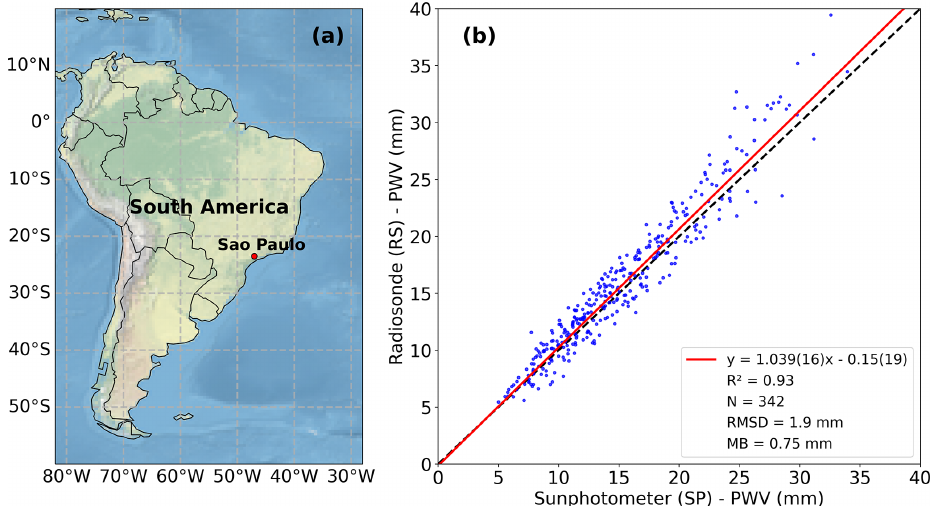
Figure 4. ( a ) Sampling site location in São Paulo, Brazil (23.56 ◦ S, 46.74 ◦ W; 786ma.s.l.). ( b ) Comparison between level-2.0 AERONET sun photometer (SP) PWV retrievals and radiosonde (RS) integrated PWV from 2001 to 2019. The regression result is shown as a continuous red line. The 1 : 1 line is shown dashed. SP data were temporally matched within 30min to daytime RS launches at 09:00LT (12:00UTC). The RS launch site is located 11km from and at an altitude 64m below the sampling site. To avoid cloudy cases, only days with at least five SP retrievals within the temporal window were considered. MB and RMSD are the mean bias and the root-mean-square deviation of RS with respect to SP